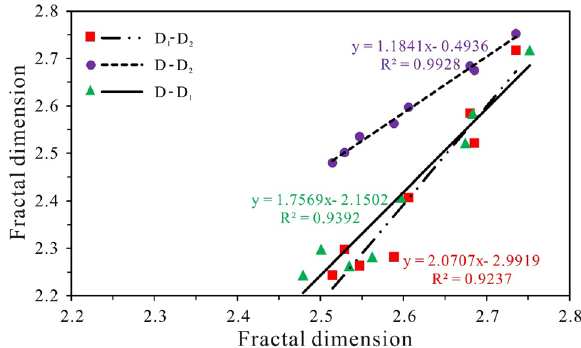
Fig. 3 Linear relationships of fractal dimension D – D D 2 in pyrolyzed oil